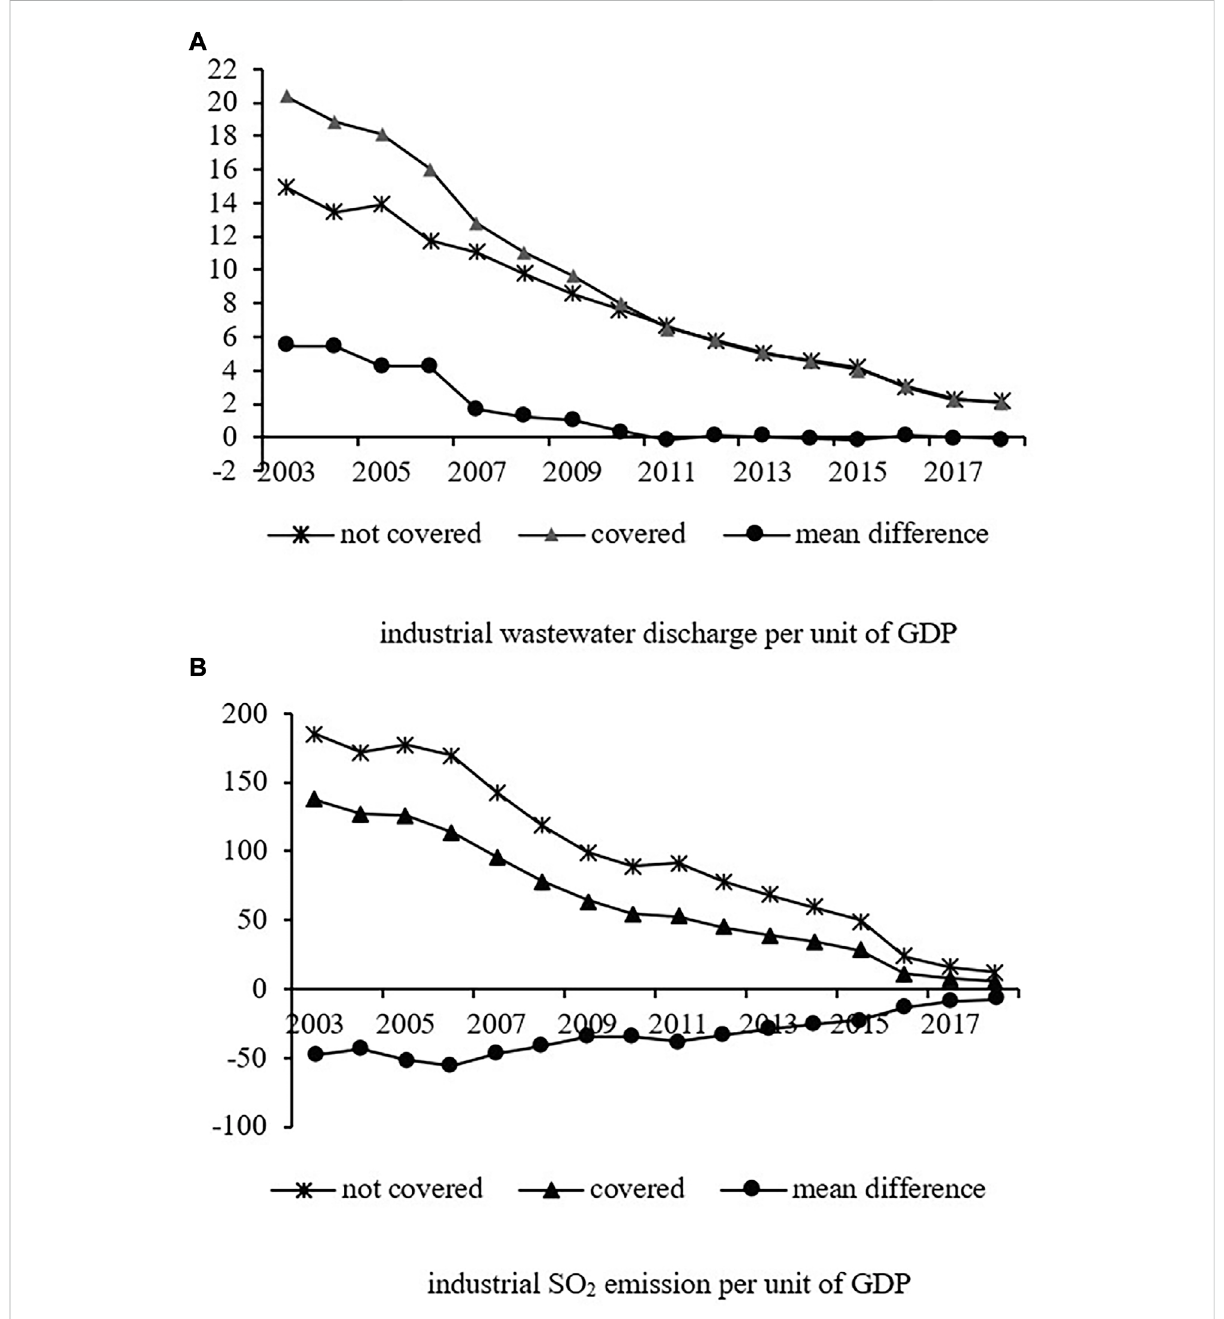
FIGURE 1 Changing trends in industrial